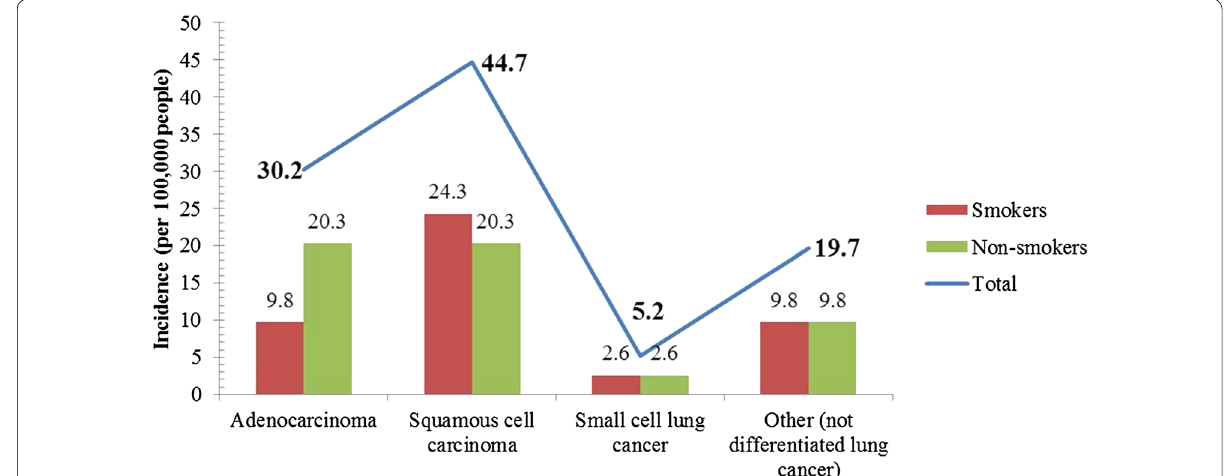
Fig. 8 Relationship of the incidence of various histological types of lung cancer with smoking in